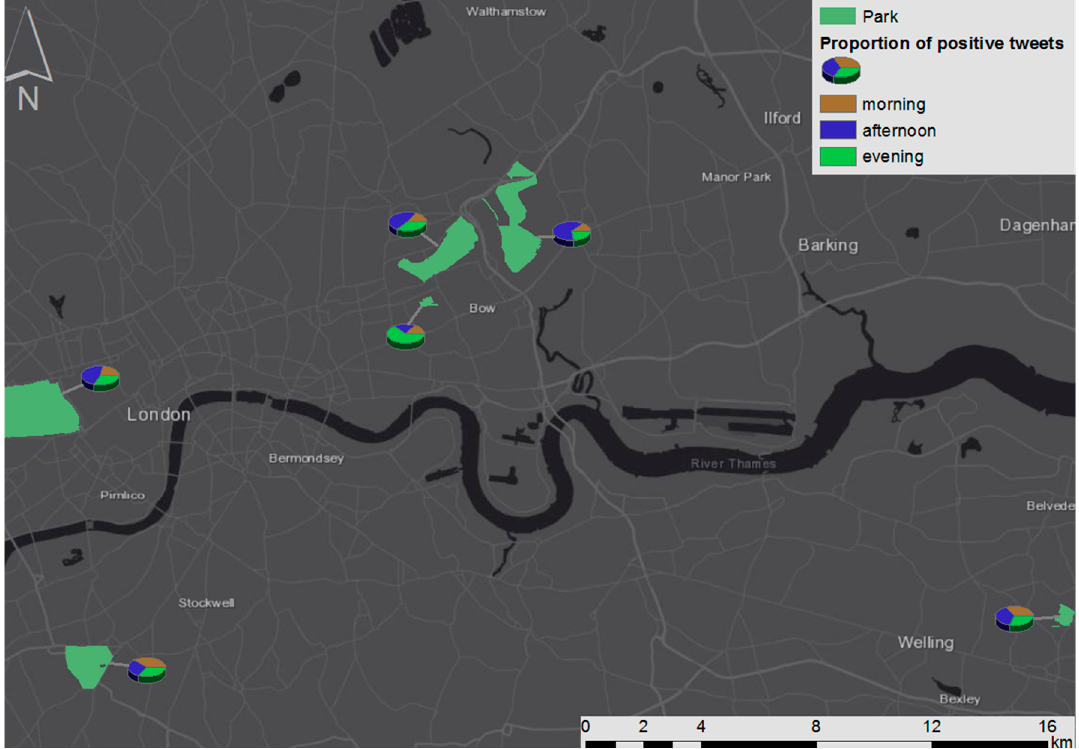
Figure 16. Proportion of positive tweets during the day at the weekends.